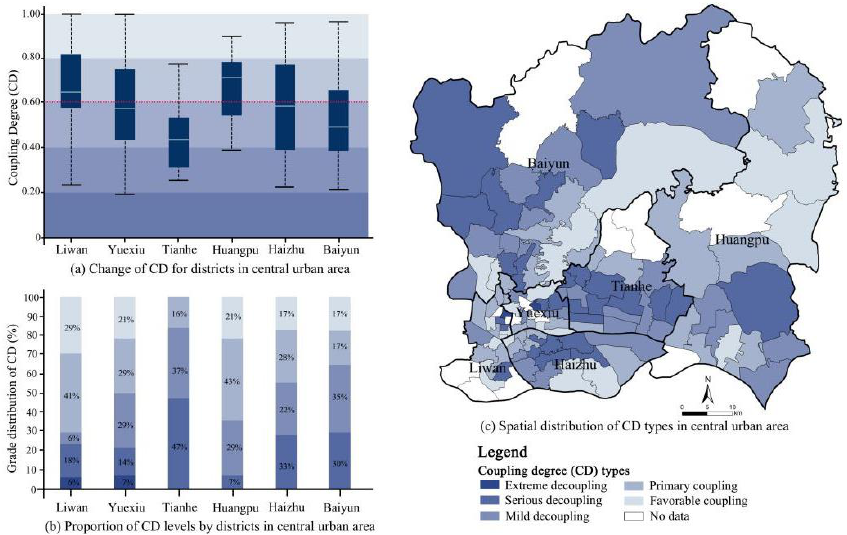
Figure 4. Mapping of Coupling Degree (CD) in the central urban districts.